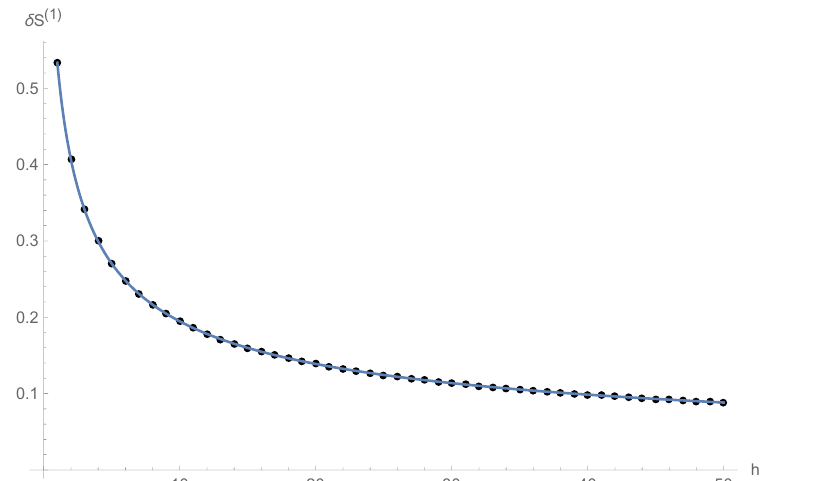
Figure 4: The black dots represent the coefficient of θ 4 h in the first order change to the entan- glement entropy. The blue line represents the absolute value of the θ 4 h coefficient appearing in the area operator, which is of opposite sign. The matching is exact and thus they